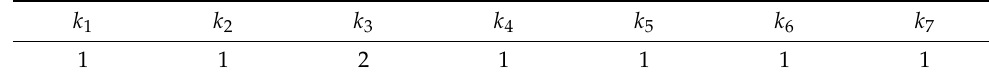
Table 2. The values of k 1 to k 7 after expanding.